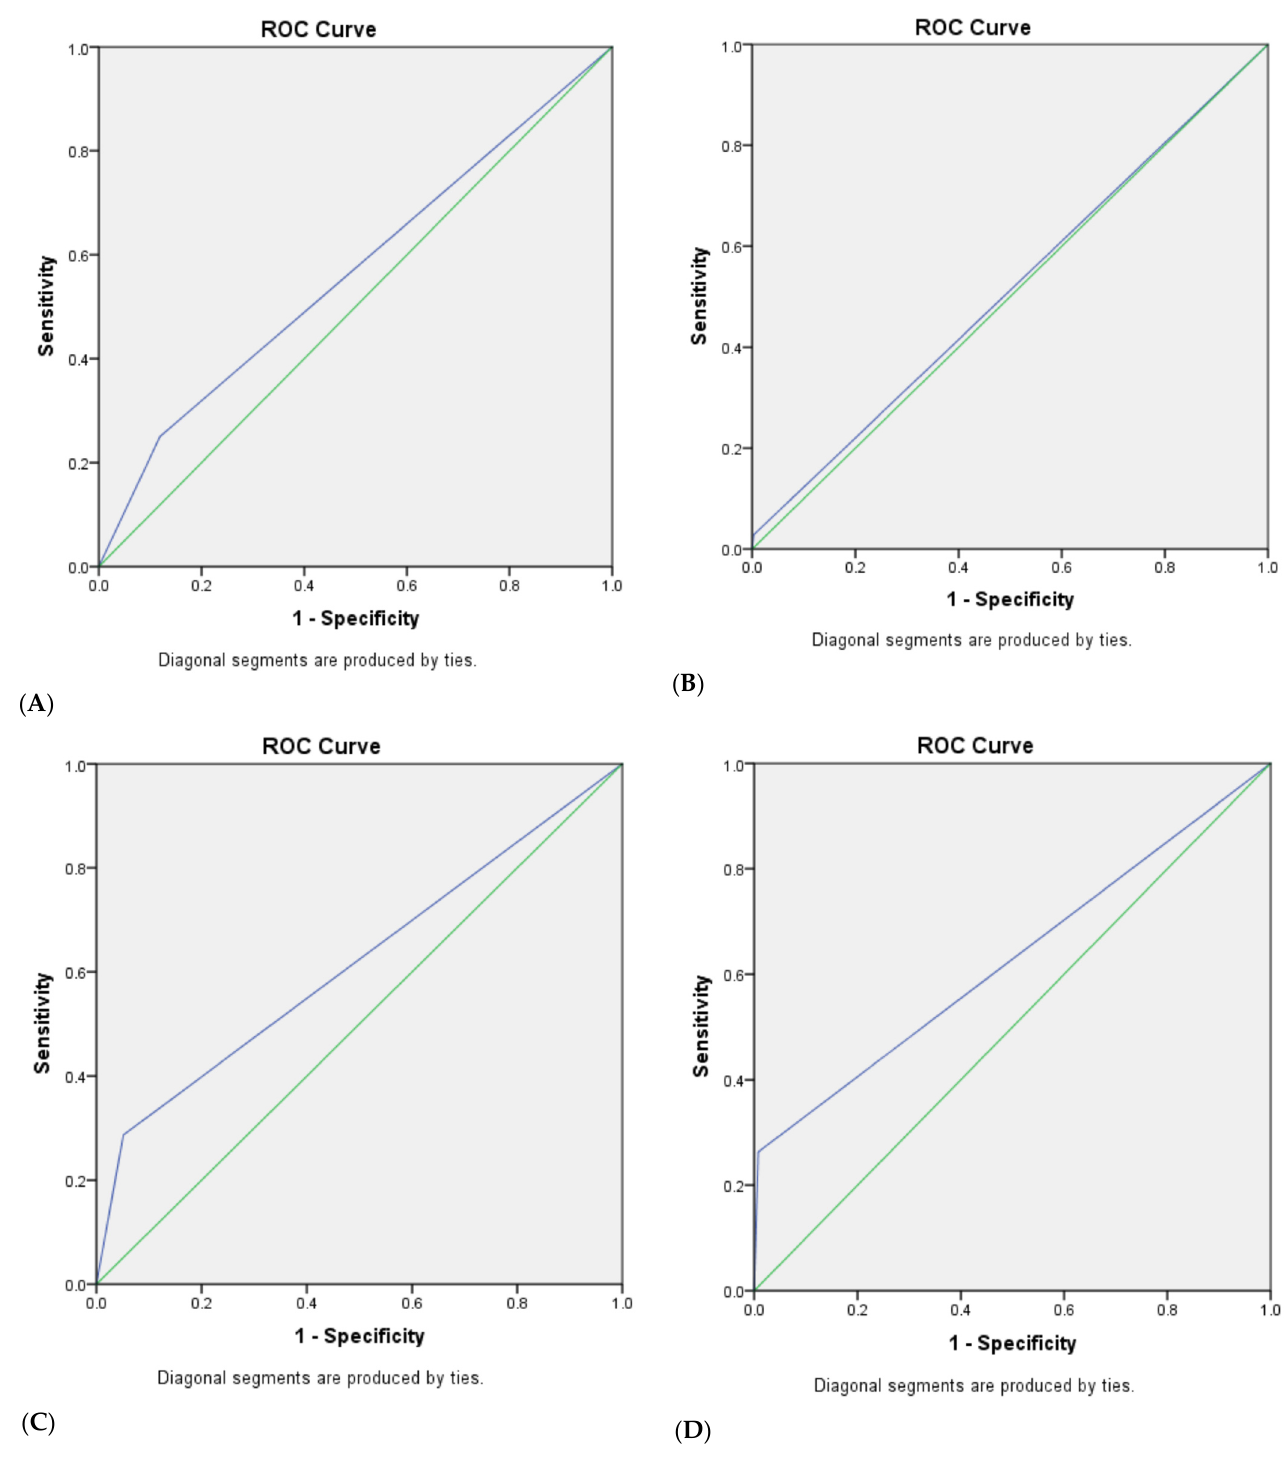
Figure 4. The ROC curve of serum tumor biomarkers. ( A ) The ROC curve of CA125 positive value; AUC: 0.566, SE: 0.033, 95% CI (0.502, 0.630). ( B ) The ROC curve of CA15-3 positive value; AUC: 0.513, SE: 0.032, 95% CI (0.450, 0.575). ( C ) The ROC curve of CA19-9 positive value; AUC: 0.618, SE: 0.033, 95% CI (0.553, 0.683). ( D ) The ROC curve of HE4 positive value; AUC: 0.628, SE: 0.036, 95% CI (0.558, 0.698).